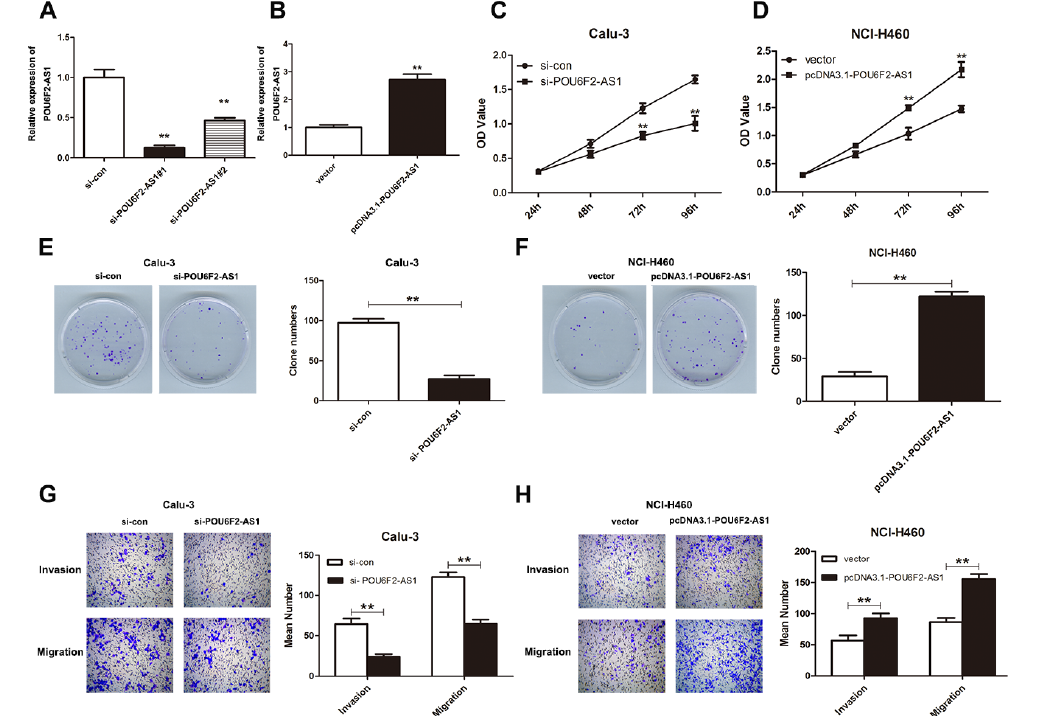
Figure 2 – Effects of POU6F2-AS1 on aggressiveness of Calu-3 and NCI-H460 cells. (A) The expression level of POU6F2-AS1 in Calu-3 cells transfected with si-con, si-POU6F2-AS1#1 and si-POU6F2-AS1#2. (B) QRT-PCR showed the expression level of POU6F2-AS1 after pcDNA3.1-POU6F2-AS1 transfection. CCK-8 assay were conducted to assess the effect of POU6F2-AS1 on proliferation of (C) Calu-3 and (D) NCI-H460 cells. Role of POU6F2- AS1 was revealed using (E) Calu-3 and (F) NCI-H460 cells in colony formation assays. (G) Calu-3 and (H) NCI-H460 cells were utilized to examine the biological influence of POU6F2-AS1, **P < 0.01.